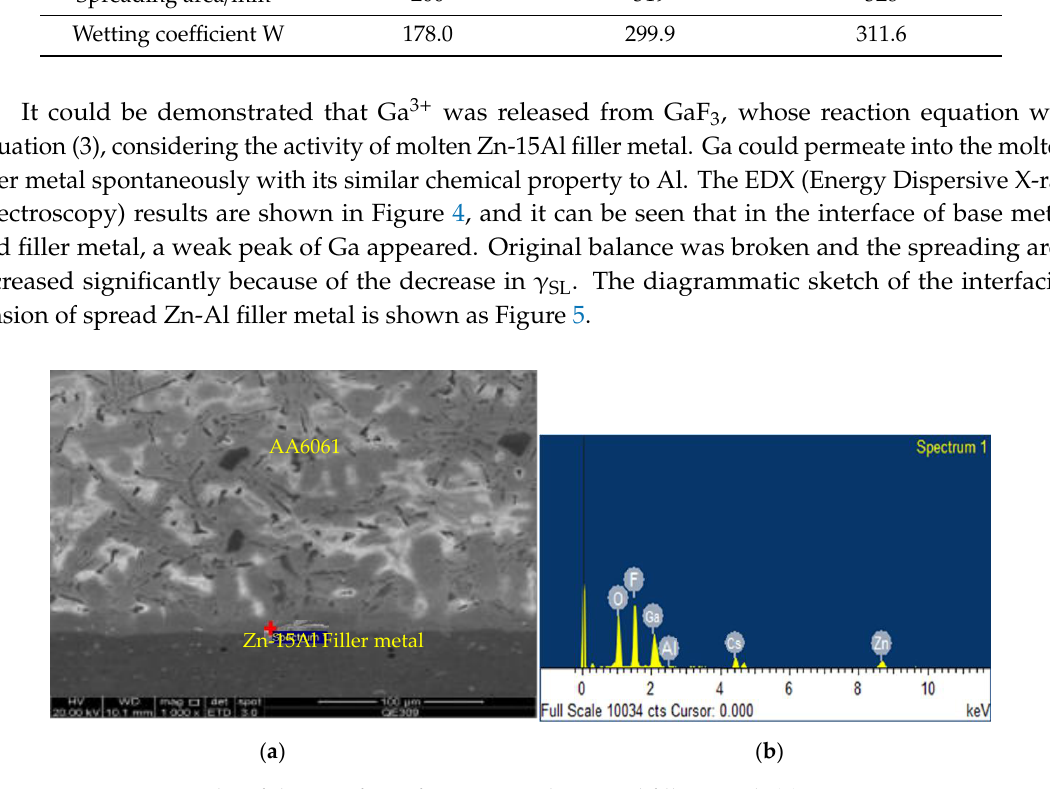
Table 3. Wetting angles of different fluxes.